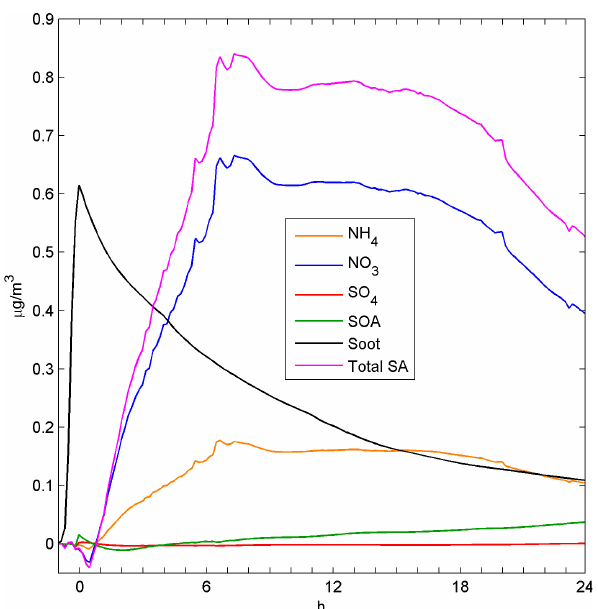
Fig. 9. Modeled average secondary aerosol (SA) formation and pri- mary soot contribution to the PM 2 . 5 mass, due to gas and particle phase emissions in Malm¨o in the surface layer downwind of Malm¨o. The effective density of the soot particle emissions over Malm¨o was estimated to be 700kgm − 3 . The organic contribution only takes into account the SOA in and downwind of Malm¨o.